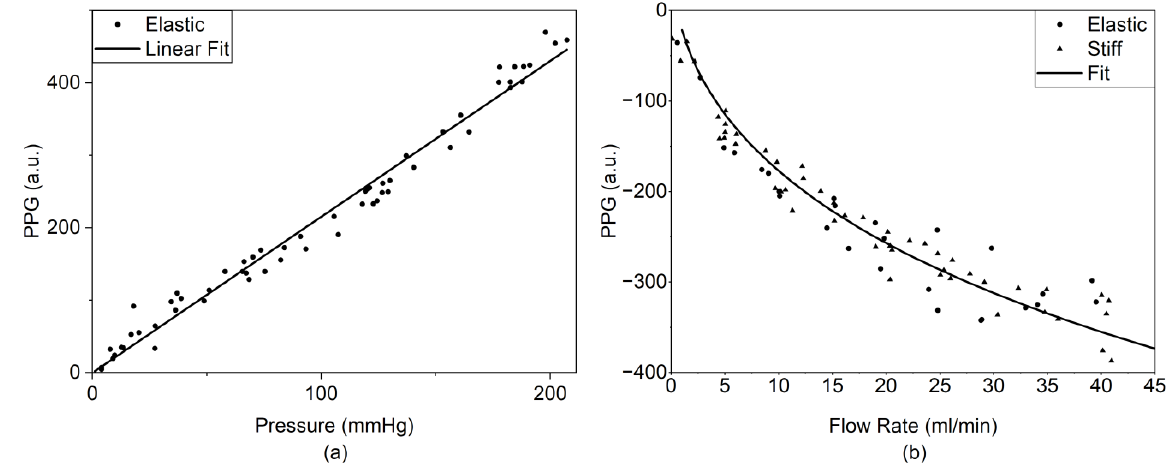
Figure 2. Experimentally measured relationships between pressure, flow rate and PPG at a wave- length of 830 nm. ( a ) The pressure – PPG relationship derived from static experiments without flow and the linear fit on the data (slope 2.15 ± 0.04 a.u./mmHg, R 2 = 0.98). ( b ) The flow – PPG relationship for elastic and stiff artery models without increase in pressure. The fitted equation corresponds to the degree of alignment of RBCs with flow (5) of the stiff models (m’ = 1613 ± 36 a.u., Q c = 328 ± 21 mL/min, R 2 = 0.99). The PPG values represent the mean value of PPG over 4 s.